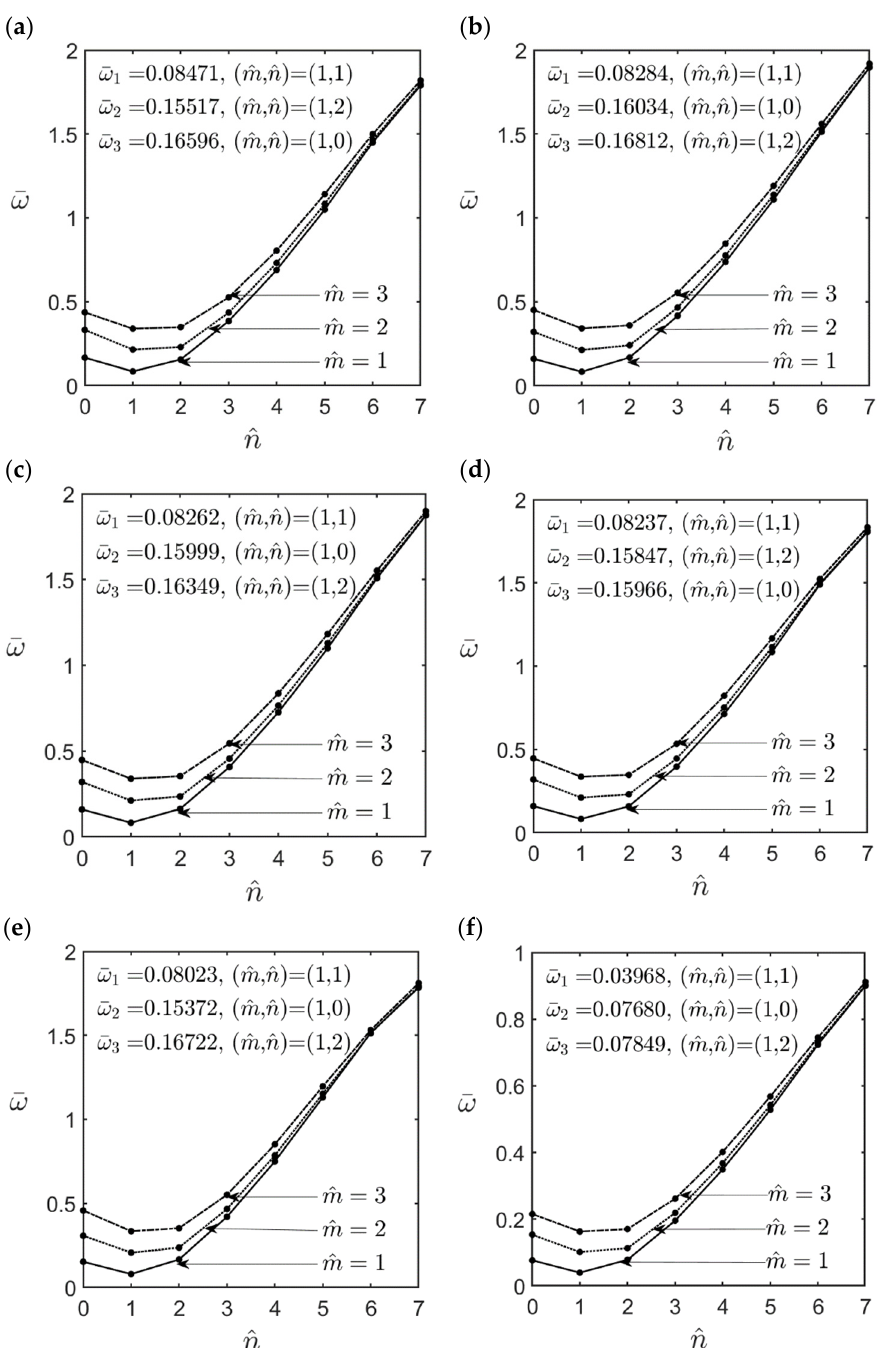
Figure 3. Variations in the lowest dimensionless natural frequencies of an FG-GPLRC thick cylindrical microshell with the wave number pairs ( ˆ m , ˆ n ) , for which R / h = 5, L / R = 5, ˆ l / h = 1.0, W ∗ GPL 0.01, and for the cases of ( a ) FG V-type, ( b ) FG X-type, ( c ) UD, ( d ) FG O-type, ( e ) FG A-type GPL distribution pa tt erns, and ( f ) homogeneous epoxy.